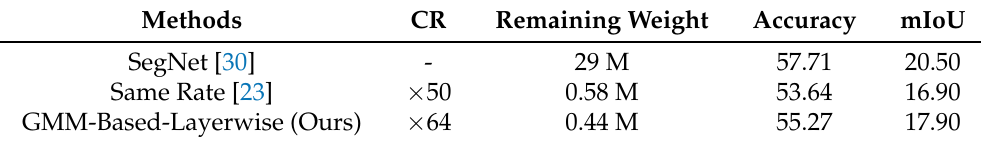
Table 4. Comparison of unstructured pruning method applying to